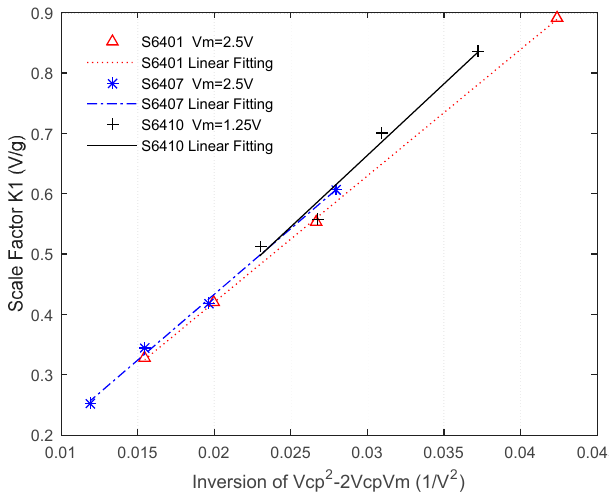
´ 2 V M V CP : For accelerometer (cid:1848) : For accelerometer CP (cid:3014) (cid:3004)(cid:3017) = 1.25 (cid:1848) , (cid:3014)